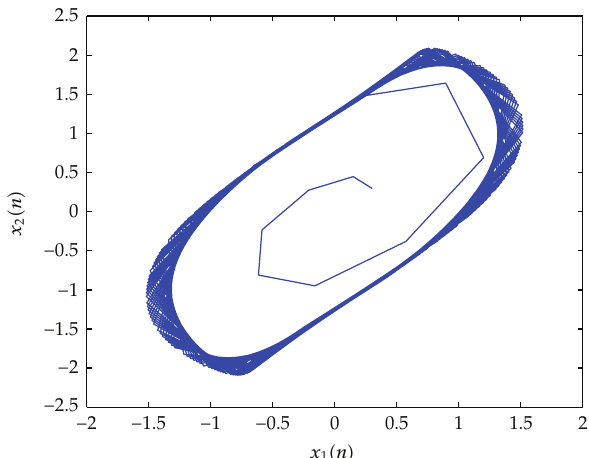
Figure 7: An invariant closed circle bifurcates from equilibrium (cid:2) 0 , 0 (cid:3) . The initial value and parameter D are (cid:2) 2 , 3 (cid:3) and 14 / 3,